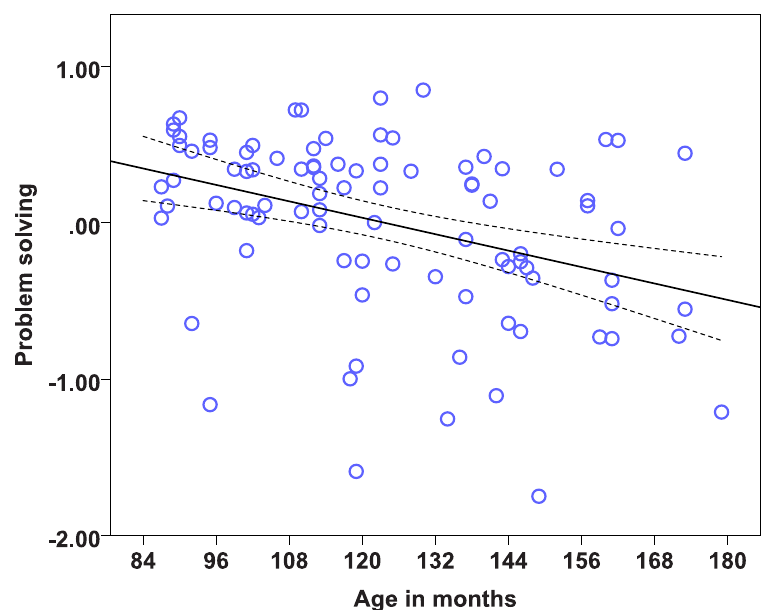
Fig 1. Scatter plots showing the relationship between age in months and problem solving [with 95% confidence intervals (dotted lines)]. A significant effect of age in months was present on the factor Problem solving ( η 2 = 0.15, p < 0.0001).